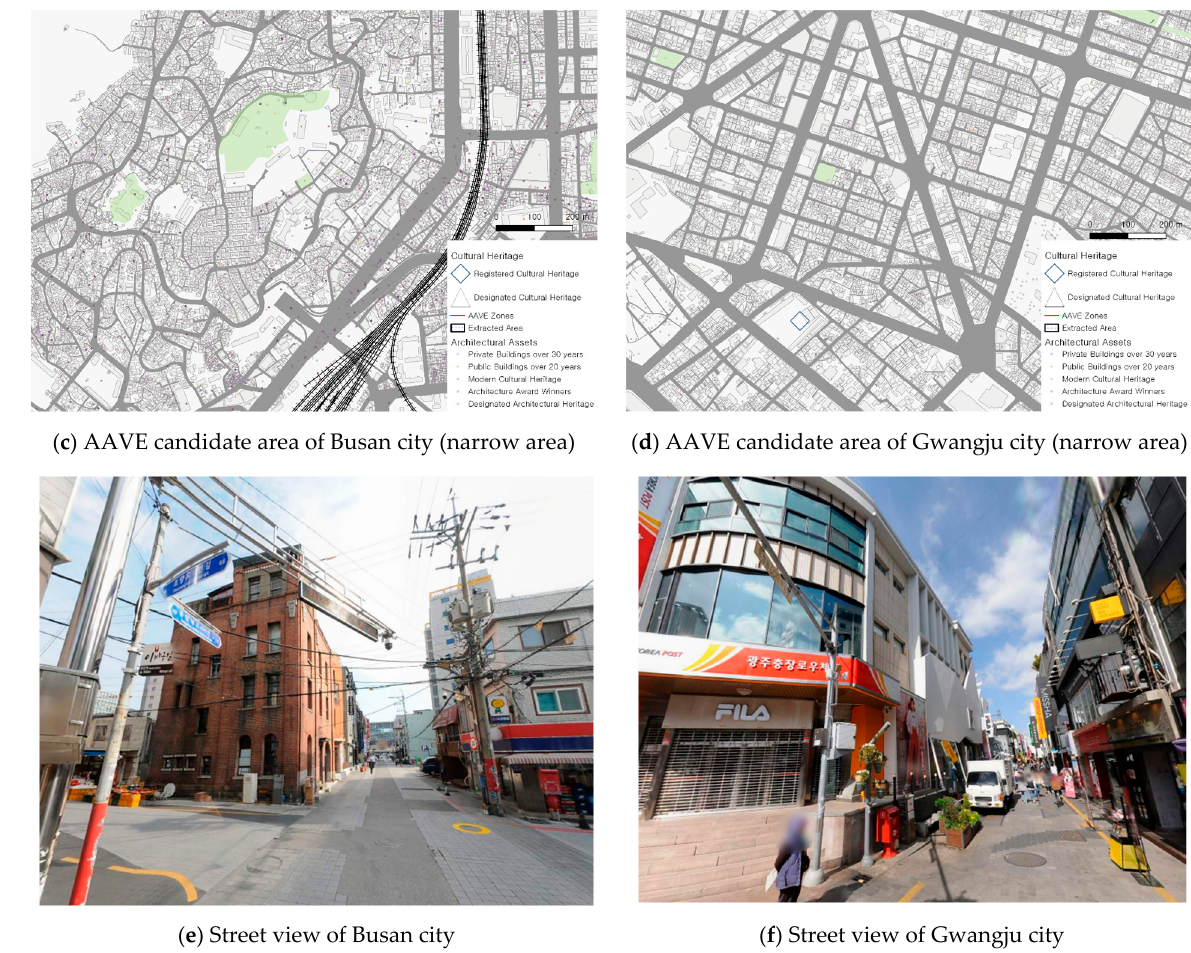
Figure 8. Review of areas with high potential for designation of AAVE zones (left, Busan city; right, Gwangju city).